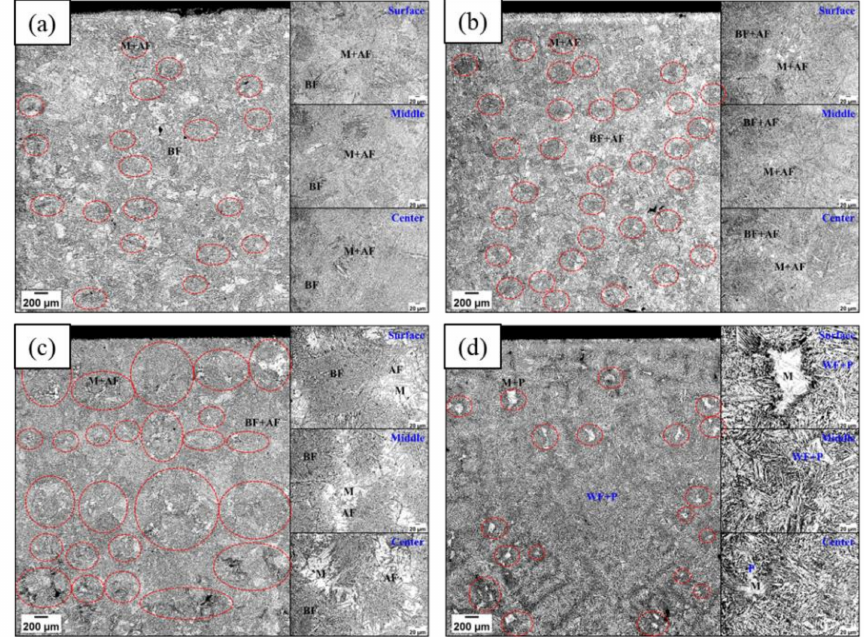
Figure 3. Microstructures of medium-carbon low-alloy steel isothermally heat treated for 240 min: